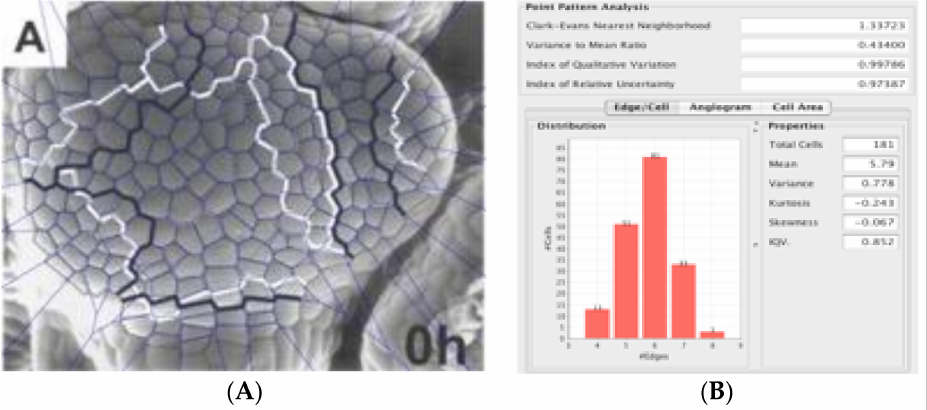
Figure 13. ( A ) We superimposed a Voronoi tessellation onto an image of “the inflorescence shoot apex of Anagallis arvensis ” (Kwiatkowska and Routier-Kierzkowska [23]). ( B ) Ka-me analysis of the Clark-Evans nearest neighborhood and variance to mean ratio for the Voronoi tessellation. Both of these measures fall outside the usual random